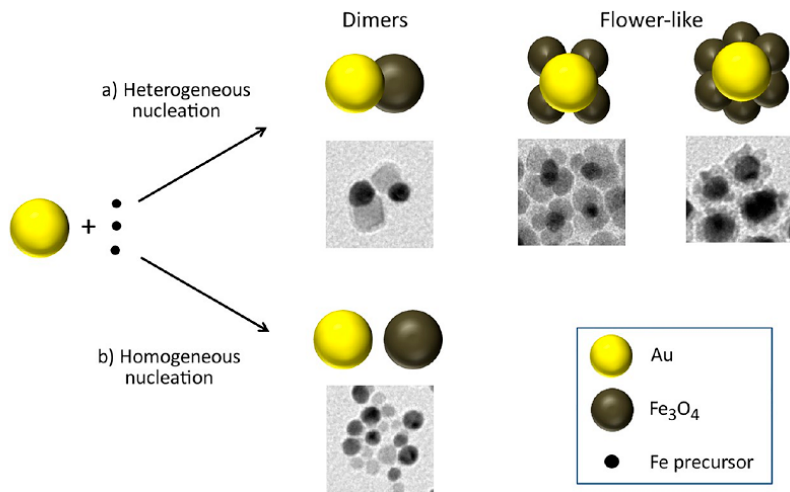
Figure 13. Schematic representation of the possible pathways of the seeded-growth reaction, starting from a mixture of Au nanocystals and molecules of iron precursor. ( a ) Heterogeneous nucleation of iron oxide, with the formation of either dimers or flower; ( b ) Homogeneous nucleation of iron oxide, with the consequent formation of isolated iron oxide particles. Reproduced with permission from [78]. American Chemical Society, 2017.